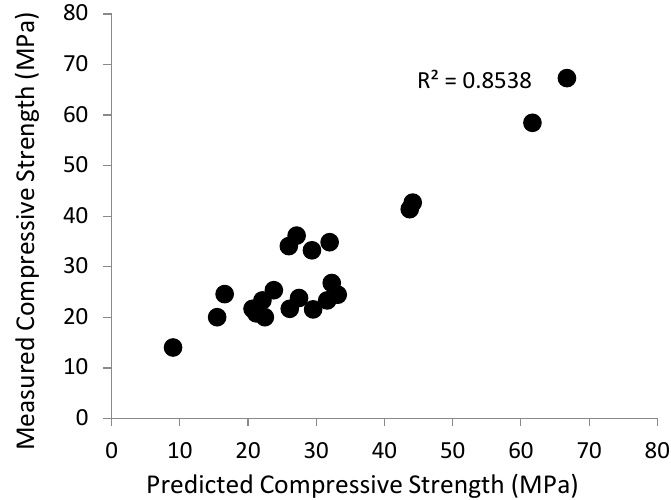
Fig. 6. Relationship between Measured and Predicted Compressive Strengths of RBAC using ANFIS Modeling.